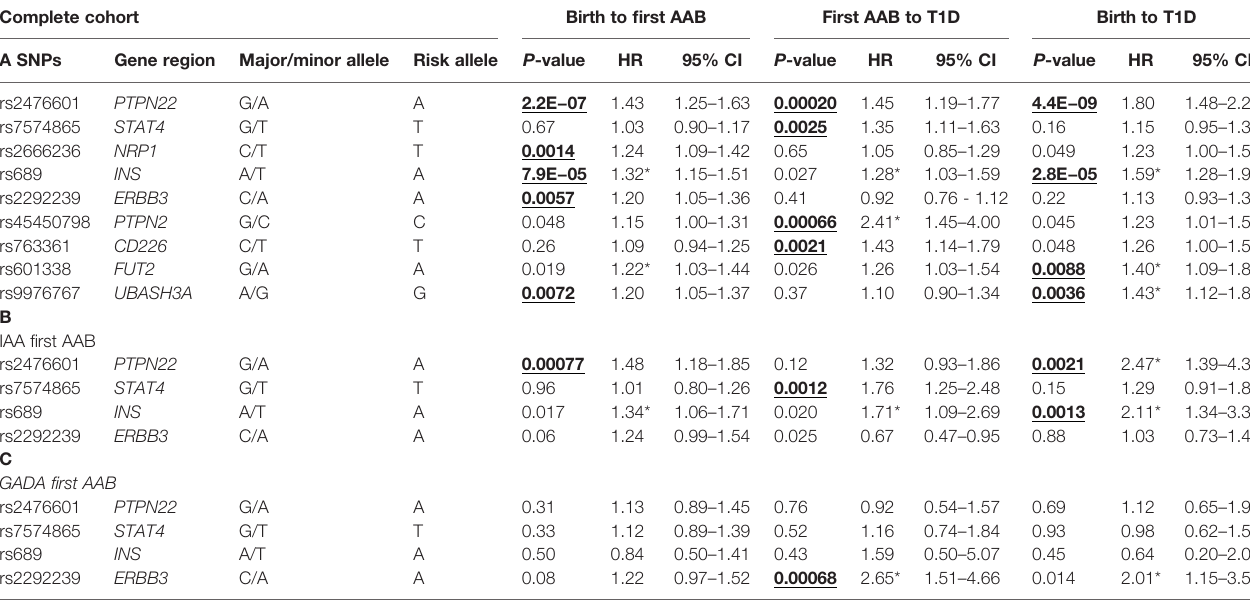
TABLE 2 | Cox regression survival analysis hazard ratios and corresponding P -values are shown for the time periods from birth to the appearance of the fi rst AAB, from the fi rst AAB to a clinical T1D diagnosis, and from birth to clinical T1D diagnosis. Complete